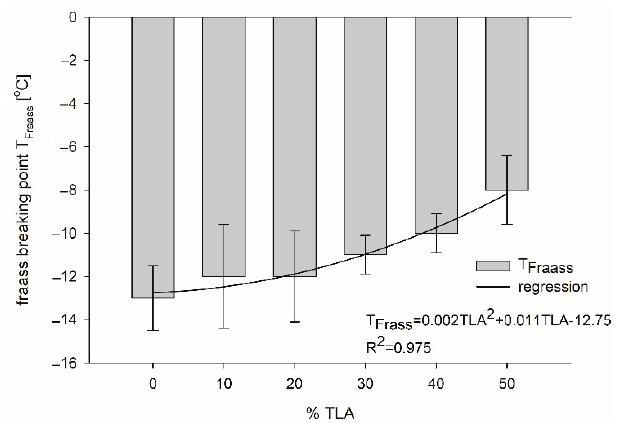
Figure 2. Softening point of TLA-modified binders.